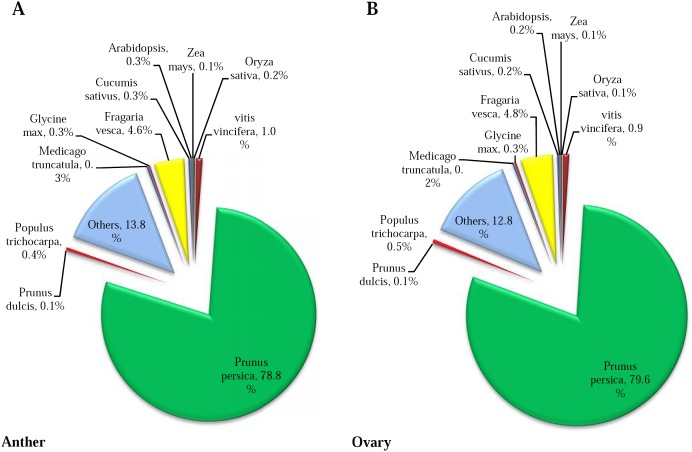
Distribution of differentially expressed genes of almond under frost stress.Venn diagram indicating the number of differentially expressed contigs under frost in anther and ovary tissues of almond.